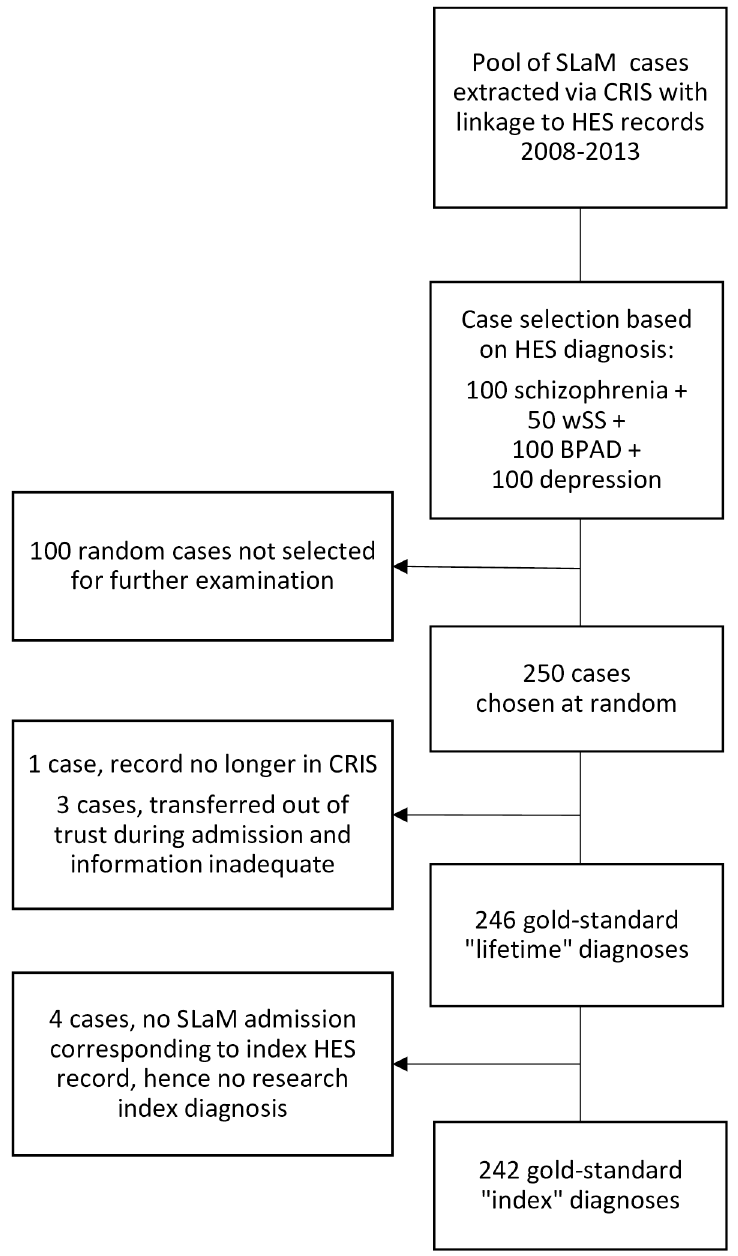
Fig 3. Flow chart of cases used to derive gold-standard diagnoses. Schizophrenia (ICD-10 F20); wSS = wider schizophrenia spectrum disorder (ICD-10 F21-29); BPAD = bipolar affective disorder (ICD-10 F30-31); depression = unipolar depression (ICD-10